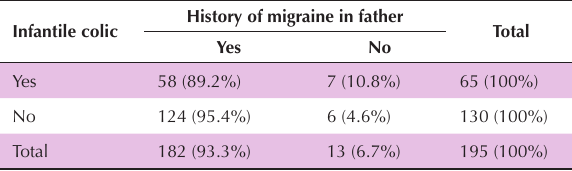
Table 5. Frequency distribution of infantile colic based on migraine history in the father Infantile colic